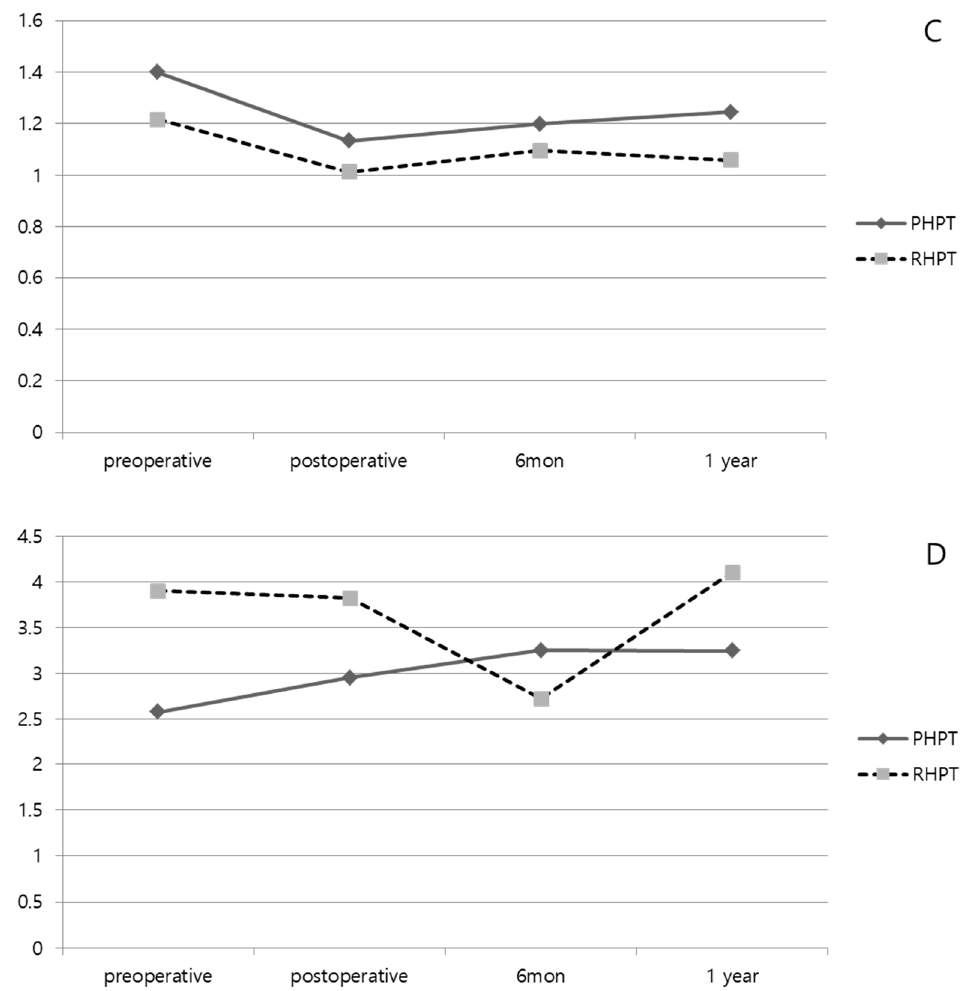
Figure 2. Laboratory results change before and after parathyroidectomy according to primary hyperparathyroidism (PHPT) and renal (secondary and tertiary) hyperparathyroidism (RHPT). ( A : PTH. B : Calcium. C : Ionized Calcium. D : Phosphate).